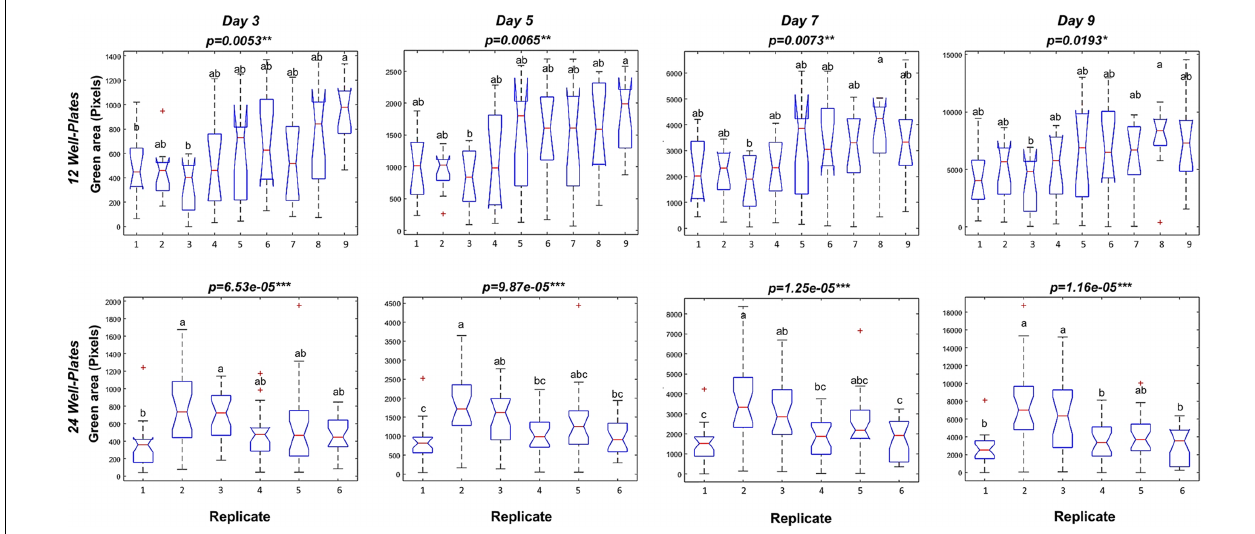
FIGURE 4 | Variation between repeated well plates in Arabidopsis rosette growth under control conditions. Box plots representing the green area (pixels) of 4 DAG Arabidopsis seedlings grown in 12-well plates (9 biological replicates) or 24 well-plates (6 biological replicates) with 1 × MS medium for 9 days. Different letters indicate significant differences according to Conover’s test after Kruskal–Wallis’ test. ∗ p < 0.05; ∗∗ p < 0.01; ∗∗∗ p < 0.001.